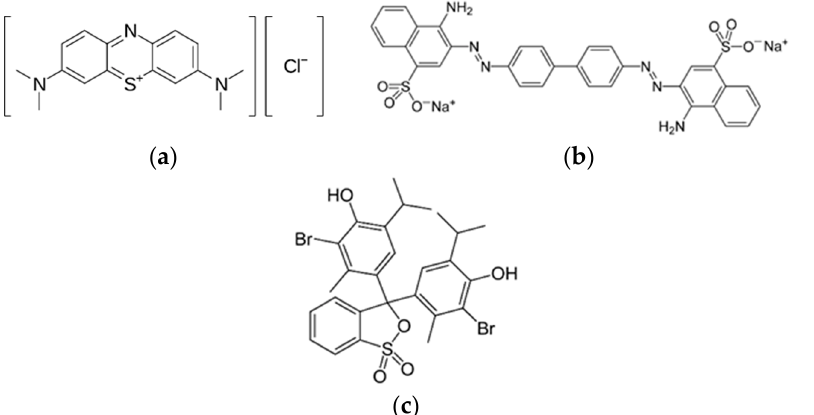
Figure 1. Dyes used for the adsorption studies: Methylene blue ( a ), Congo red ( b ), and bromothymol blue ( c